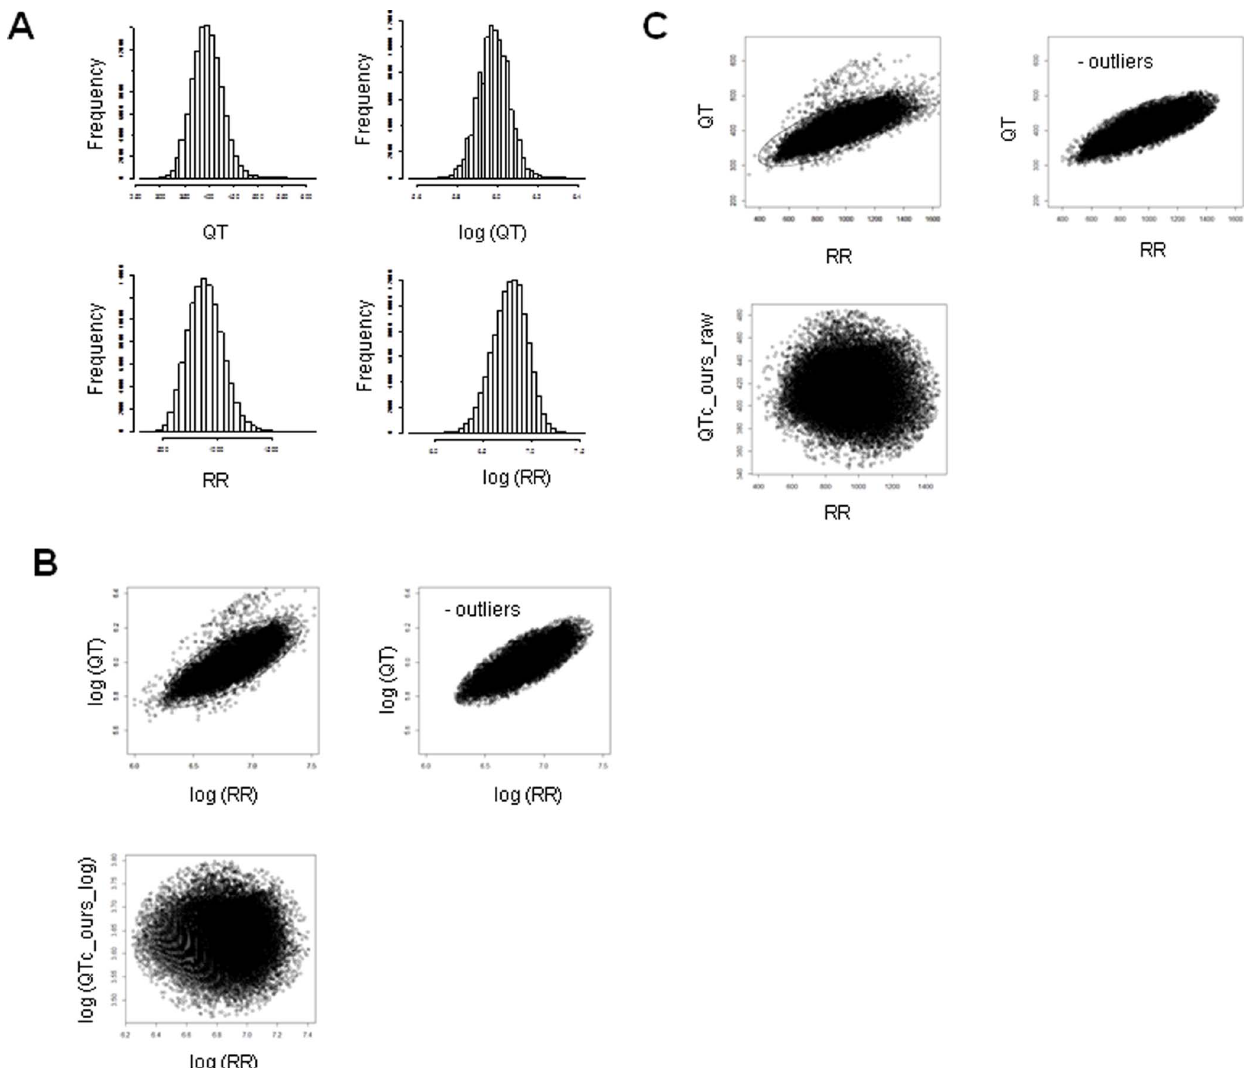
Figure 2. Analysis of resting Nihon Kohden ECGs. (A) Histograms of QT, log-transformed QT, RR, and log-transformed RR intervals. (B) Scatter plots of log QT versus log RR and log QTc_ours log versus log RR. (C) QT versus RR and QTc_ours raw versus RR. Units of all variables are ms.